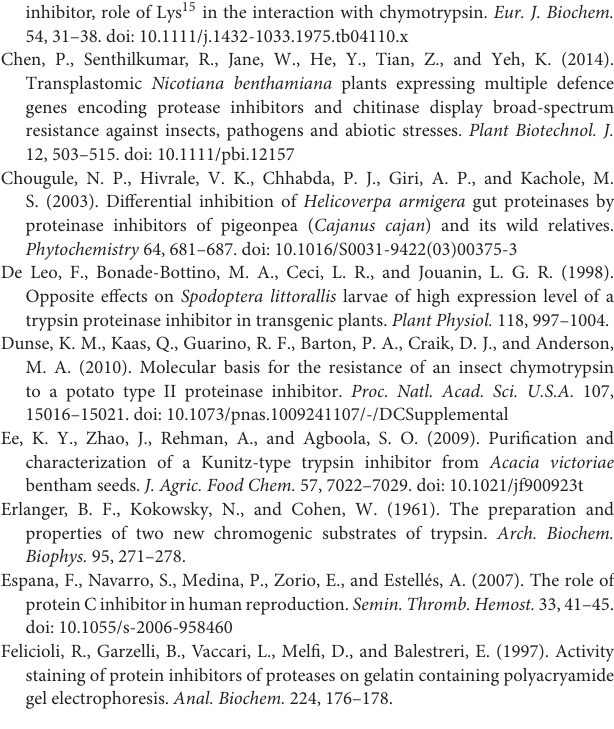
Figure S1 | The ESI MS-MS analysis of isoinhibitor spot (pI 6.6) of CpPI 63 separated in 2-D gel under reducing conditions. (A) The representative fragmentation spectrum of precursor ion m/z 1465.07 generated after digestion of isoinhibitor spot with chymotrypsin; (B) The details of Mascot search corresponding to ESI-MS/MS of precursor ion m/z 1465.07; (C) Fragmentation table showing the “b” and “y” ion series matching the spectrum along with the mass differences of the ions; (D) the corresponding de novo sequence “LLLVAPPPGPAVAHL” and (E) The alignment of de novo amino acid sequence with related proteins: Xylanase inhibitor from Japanese rice Oryza sativa (Nr:Q53NL5.1; GI:73622089); Amylase inhibitor from Zea mays